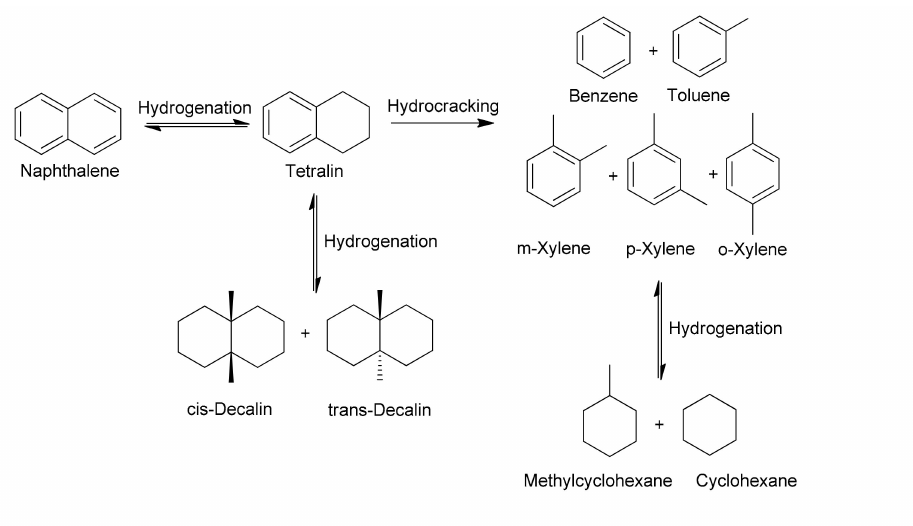
Table 1. Detailed composition of naphthalene hydrocracking products for NiWS-HY(1%), W = 4% catalysts at standard conditions P = 5 MPa, t = 5 h, and W:Ni ratio = 1:2. Compound Amount (wt %) Compound Methylcyclopentane 0.47 Benzene 2.84 3-Methylhexane 0.39 Methylcyclohexane